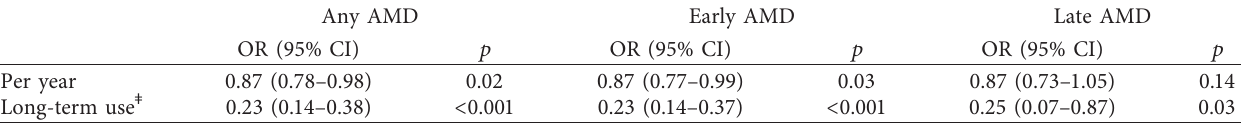
Table 4: Multivariate-adjusted ORs for any AMD in relation to RASI treatment duration among RASI users. Any AMD